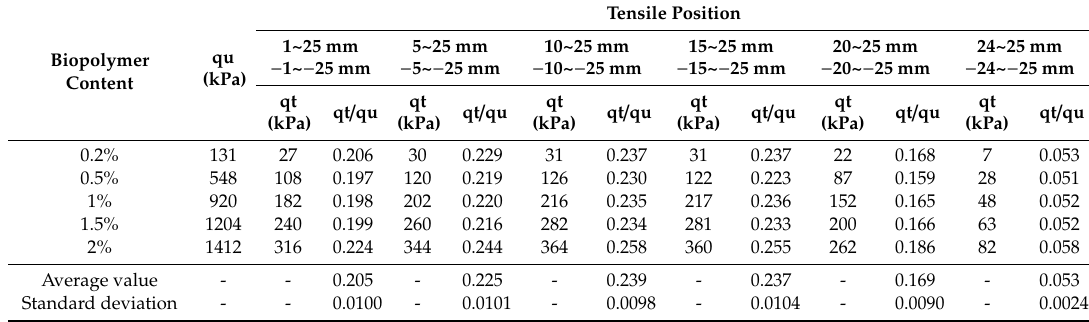
Table 2. Biopolymer treated soil tensile strength (qt), uniaxial compressive strength (qu) and the calculation of qt /